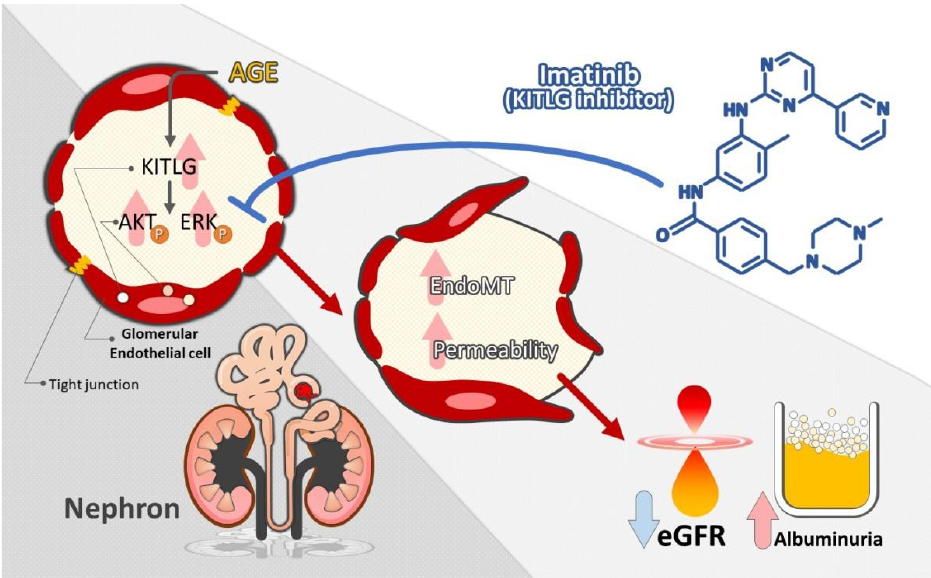
Figure 7. Illustration of the mechanism by which AGEs induce EndoMT and the increase in the permeability of GECs through the KITLG/AKT/ERK1/2 pathway and urinary KITLG as a biomarker of kidney injury in type 2 DM. Furthermore, imatinib reversed AGE-induced EndoMT and impaired the permeability of GECs.